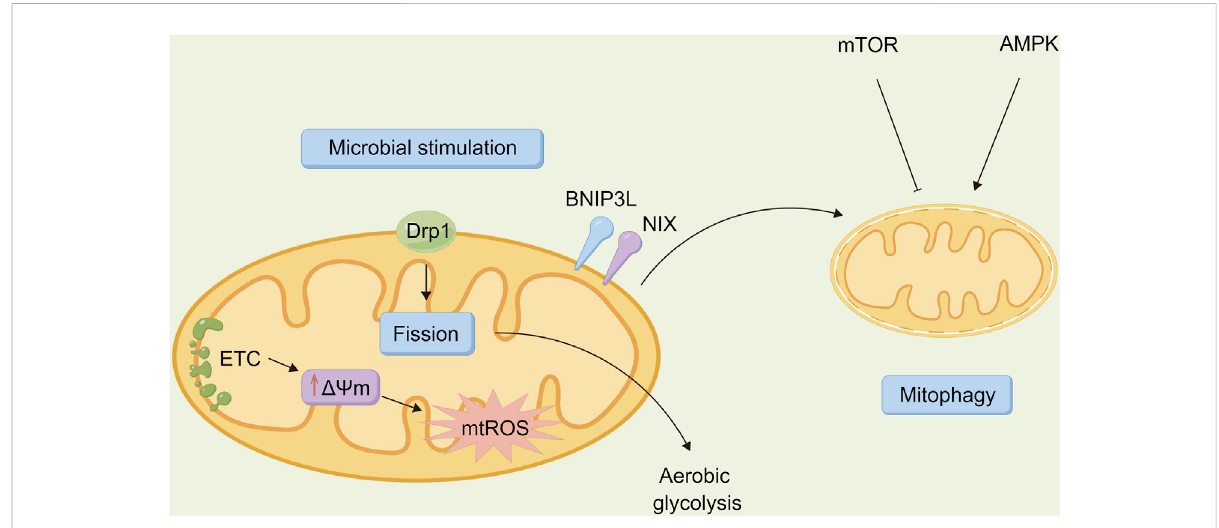
FIGURE 3 Relationship between autophagy and microbiota. Autophagy is a “ double-edged sword ” that is involved in host defense against pathogen infection, allowing invading bacteria to be transported to lysosomes for degradation via lipid raft mediated endocytosis. However, it can also be a uniquestrategyforcertainpathogenicbacteriatoevadeimmunesurveillance,therebypromotingthesurvival,proliferation,andextentofinfectionin the incoming